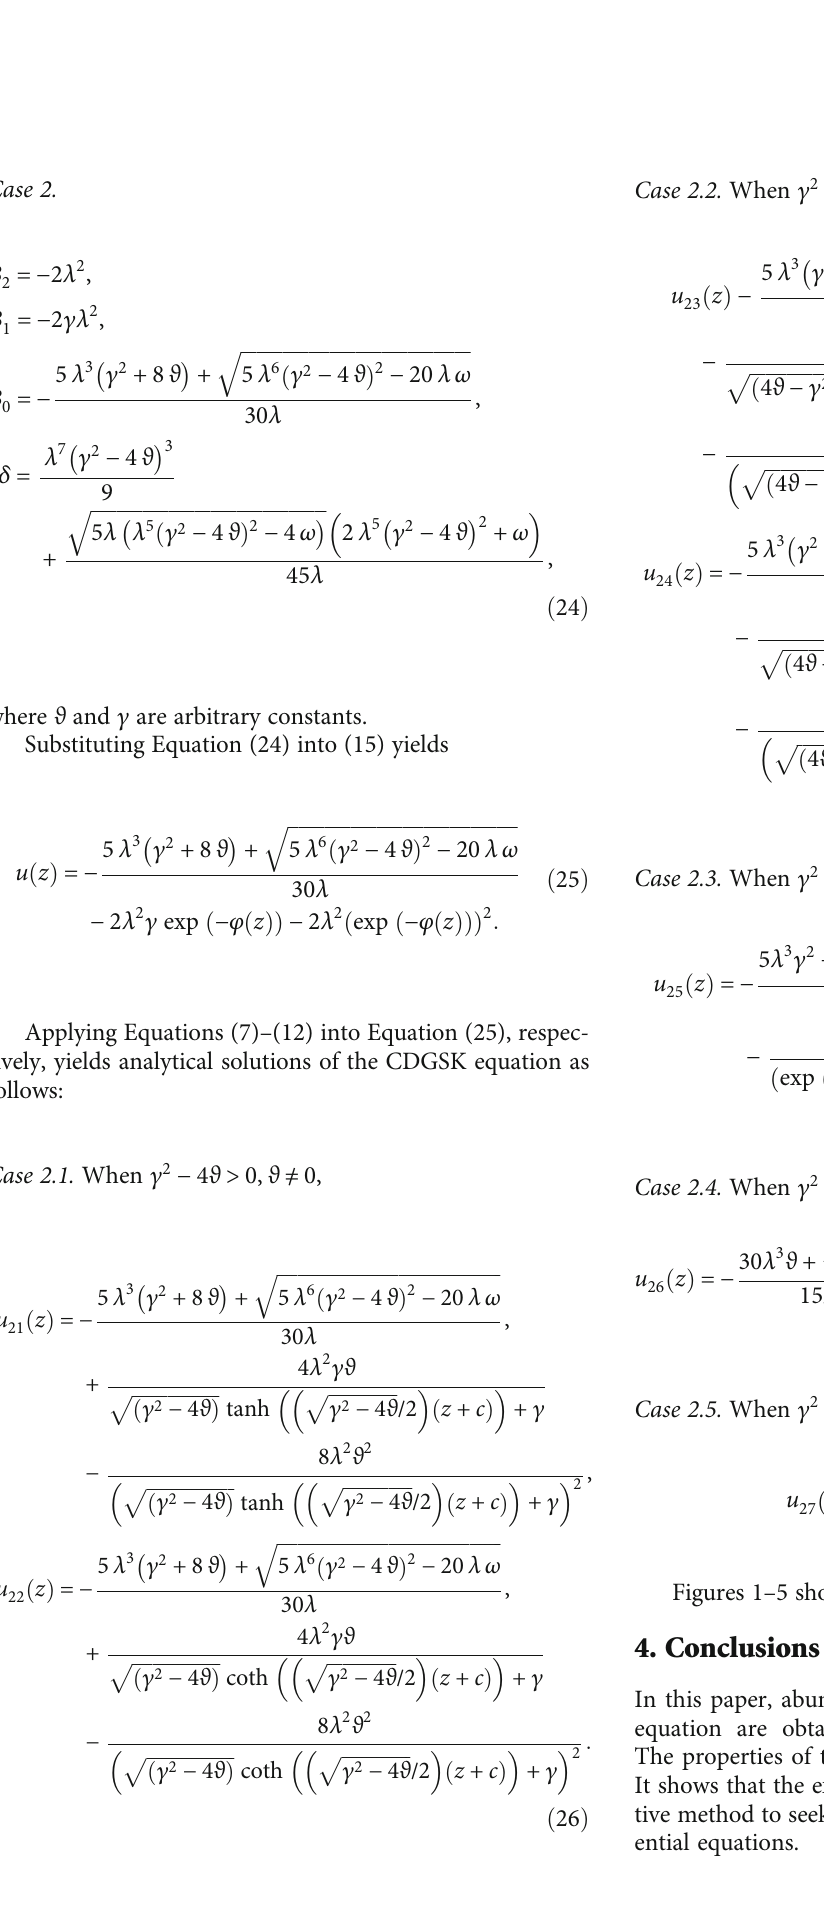
ffiffiffiffiffiffiffiffiffiffiffiffiffiffiffiffiffiffi ffiffiffiffiffiffiffiffiffiffiffiffiffiffi ffiffiffiffiffiffiffiffiffiffiffiffiffiffiffiffiffiffi p 4 ϑ − γ 2 ð Þ